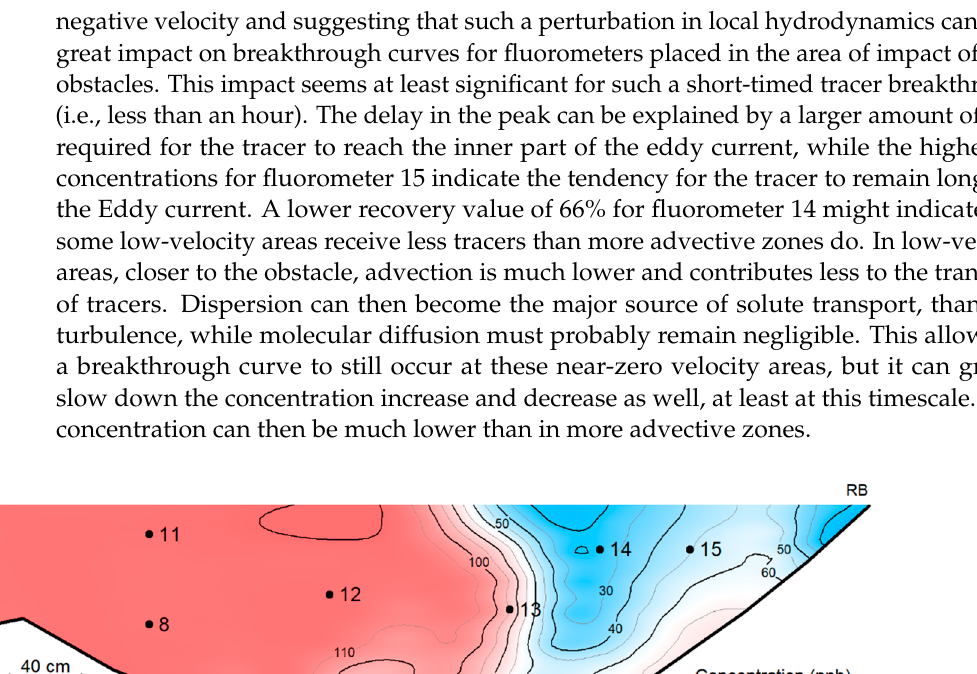
Figure 9. Simulated streamlines at cross-section 1 (flow is from left to right). The eddy circulation is clearly visible on the right side of the stream.